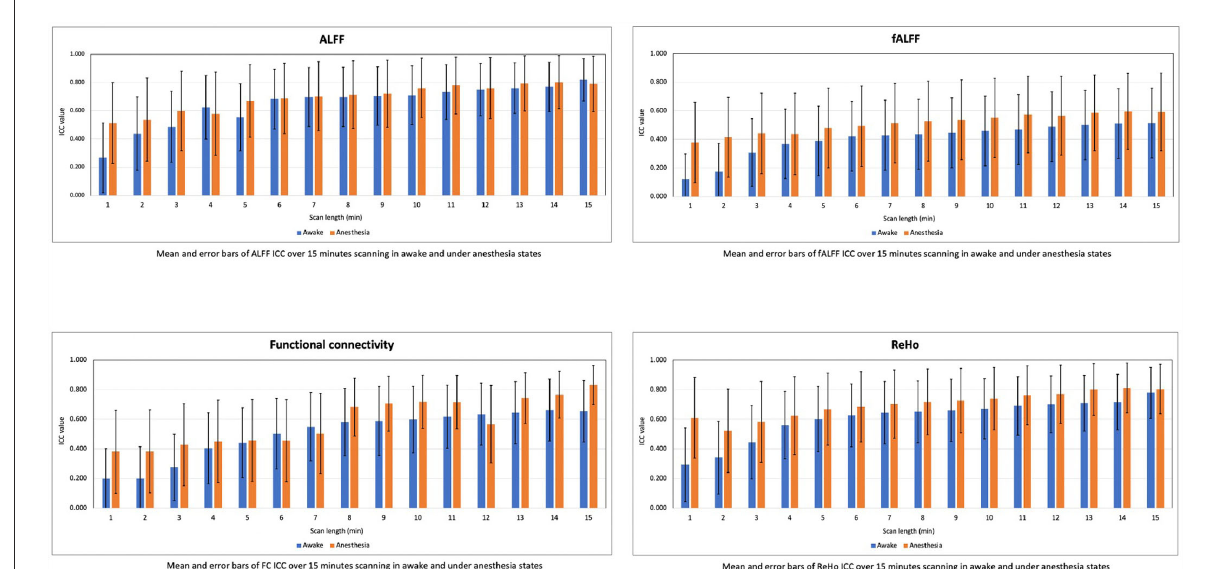
FIGURE4 Scatter plots and standardized logarithmic fits of ICC of rs-fMRI metrics including the amplitude of low-frequency fluctuation (ALFF), fractional amplitude of low-frequency fluctuation (fALFF), functional connectivity (FC), and regional homogeneity (ReHo).